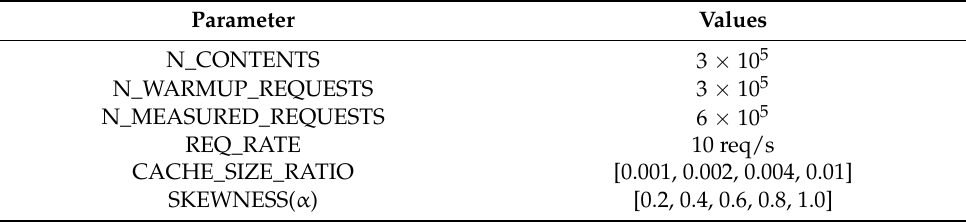
Table 2. Experiment